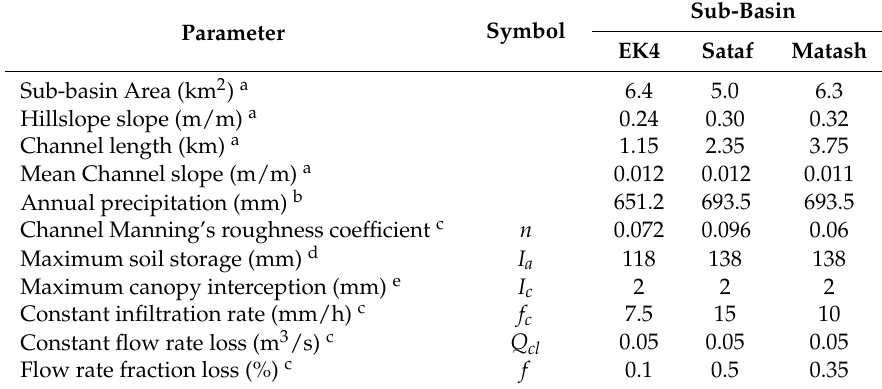
Table 1. Flow model